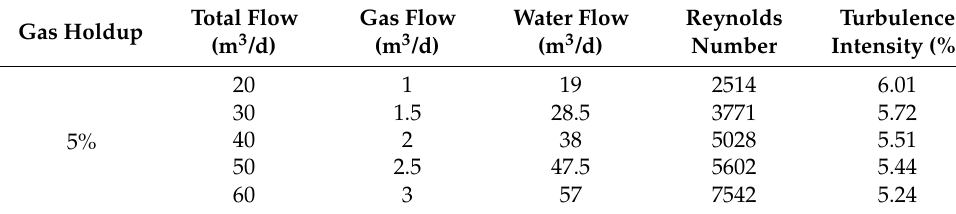
Table 1. Related parameters of gas–water two-phase flow with 5% and 10% gas holdup. Gas